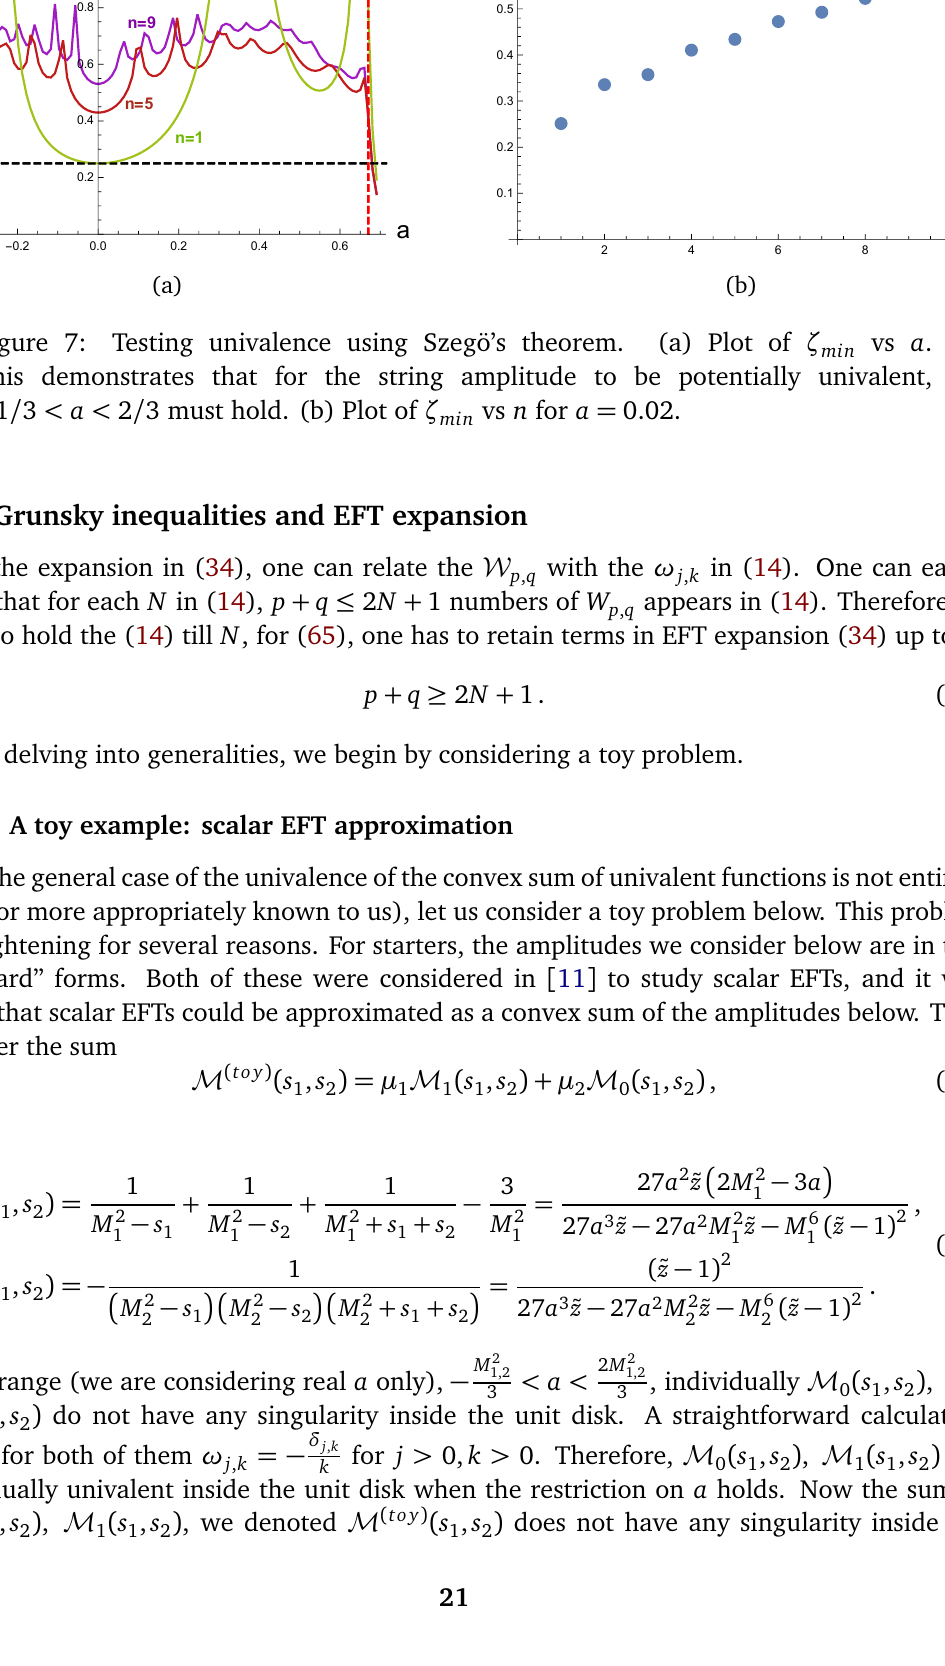
Figure 7: Testing univalence using Szegö’s theorem. (a) Plot of ζ